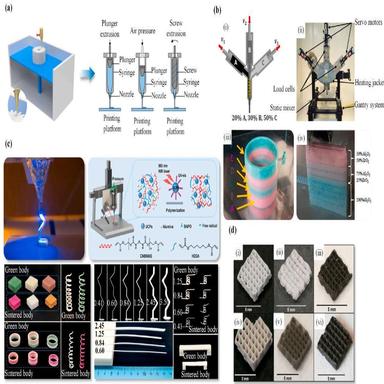
Classification of DIW (a) and its research progress: (b) triple extrusion system and CaCO3 test samples with gradient colors, Al2O3 and ZrO2 composite ceramic samples, (c) NIR-assisted DIW technology and unsupported printed lattice structures, torsion springs, and cantilever beams, and (d) micrometer-sized SiOC ceramic structures based on DIW printing. (For interpretation of the references to color in this figure legend, the reader is referred to the Web version of